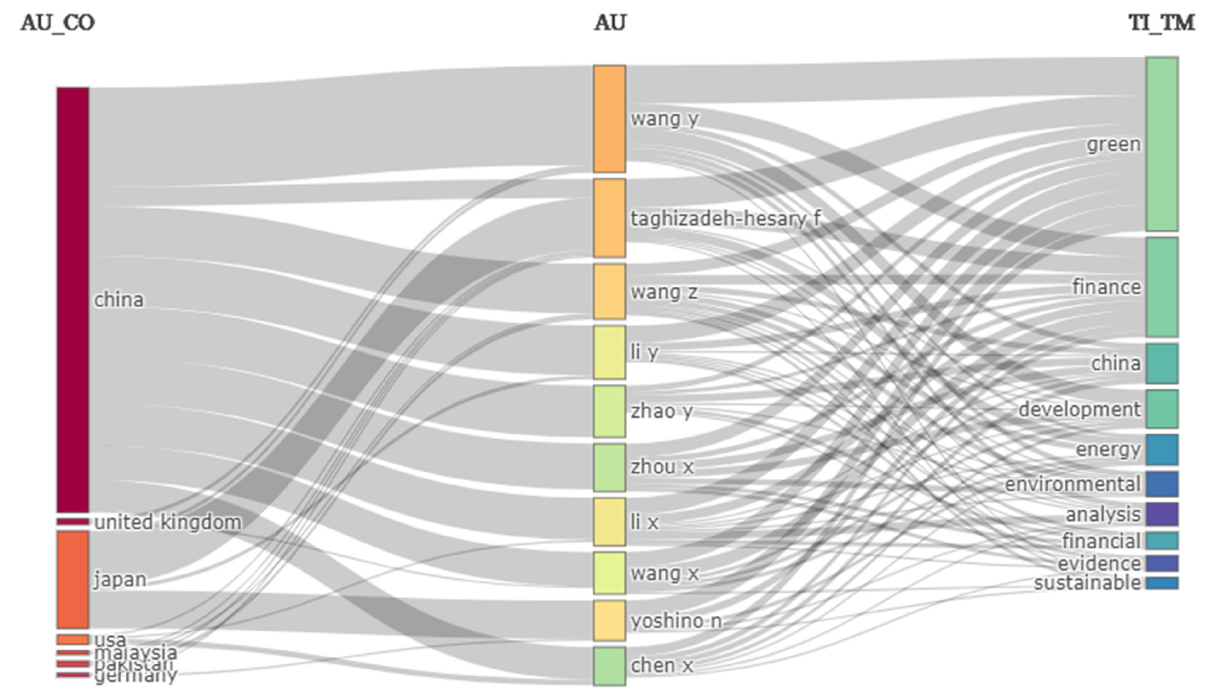
Figure 6. Mapping citation analysis. Note: Left side: countries. Middle side: authors name. Right side: title. The left side of the figure shows those authors and document countries most cited in specific study area (china, United Kingdom, Japan, USA, Malaysia, Pakistan, and Germany).